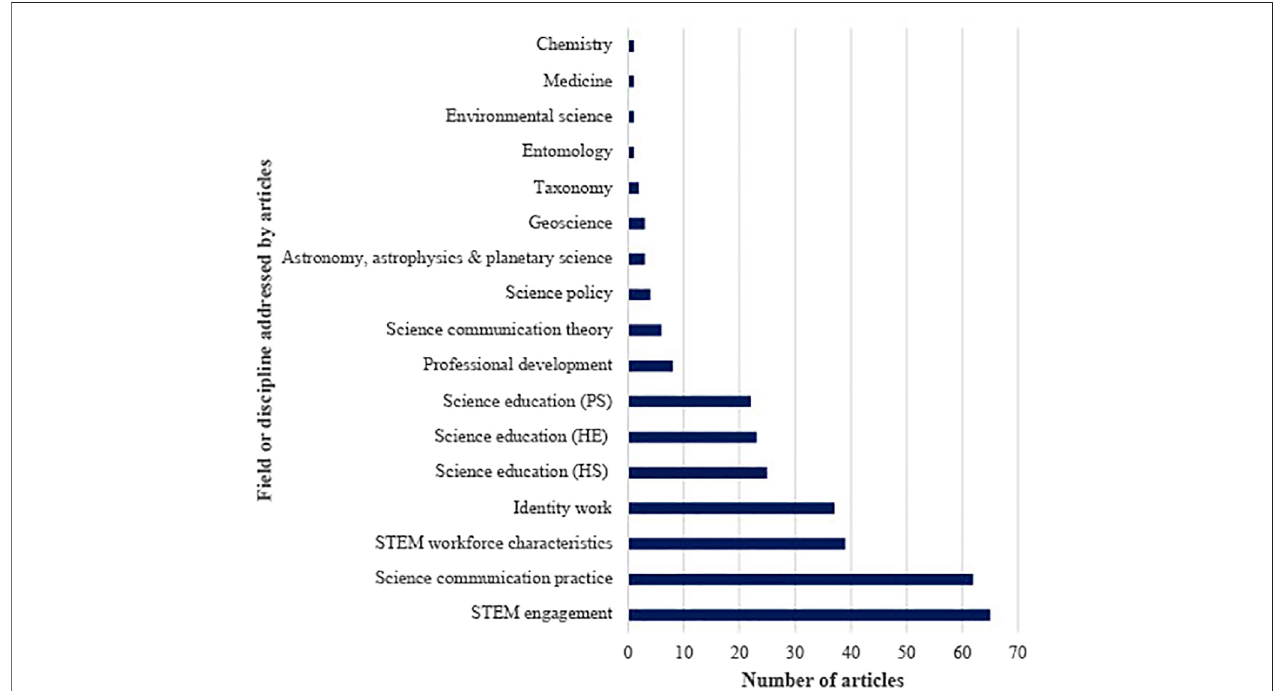
FIGURE 6 | Fields of study of articles in sample. Ninety (90) articles had both a primary and secondary fi eld, with the remainder having only a primary fi eld, so the total count of fi elds exceeds the sample size ( n (cid:1) 213).